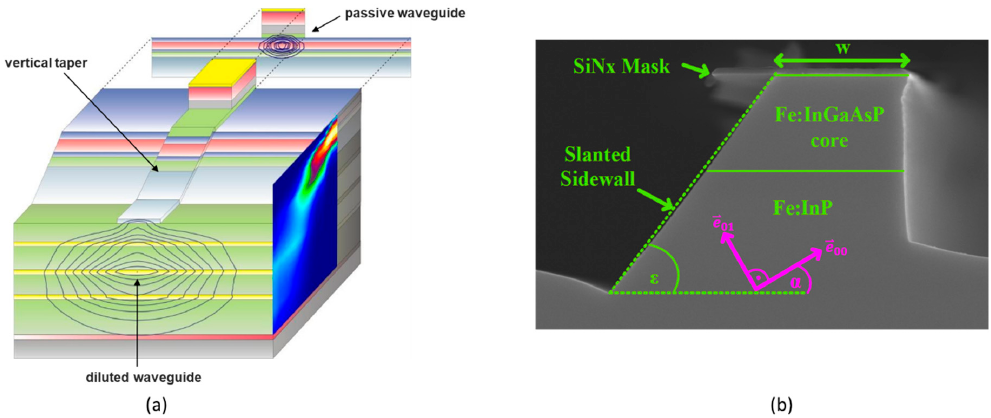
Figure 2. Schematic of the spot-size converter seen in a bird´s view perspective with a plot of a simulation of the light propagation on the side ( a ), and a scanning-electron-microscope (SEM) photograph of the asymmetric waveguide used in the polarization rotator ( b ).